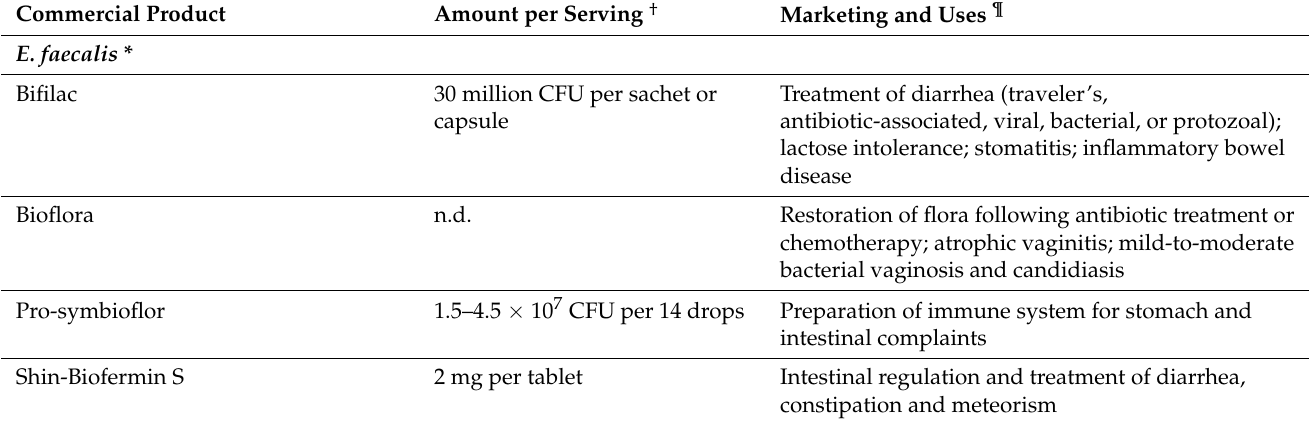
Table 1. Selected enterococcal strains as probiotics for human consumption (adapted from [43] with modifications). Commercial